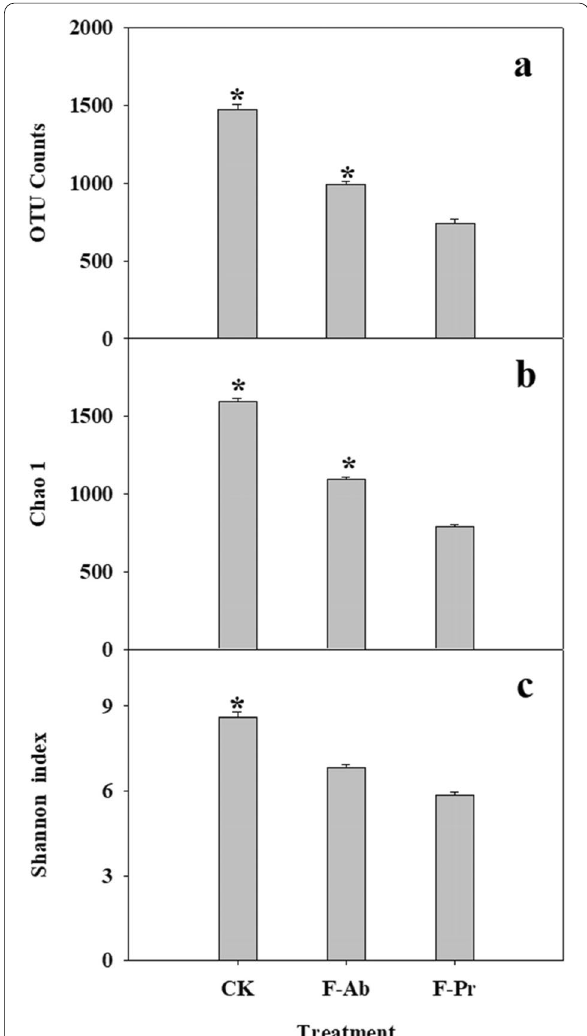
Fig. 1 Estimated number of observed a OTUs counts, b Shannon index, c Chao1 index of soil microbiome of tea plantation across all the covering Litsea cubeba plots. Values are means star (*) indicates significant difference between treatments at 0.05 level; CK, control; F‑Ab, the vegetative branches cover treatment; F‑Pr, the fruit‑bearing branches cover